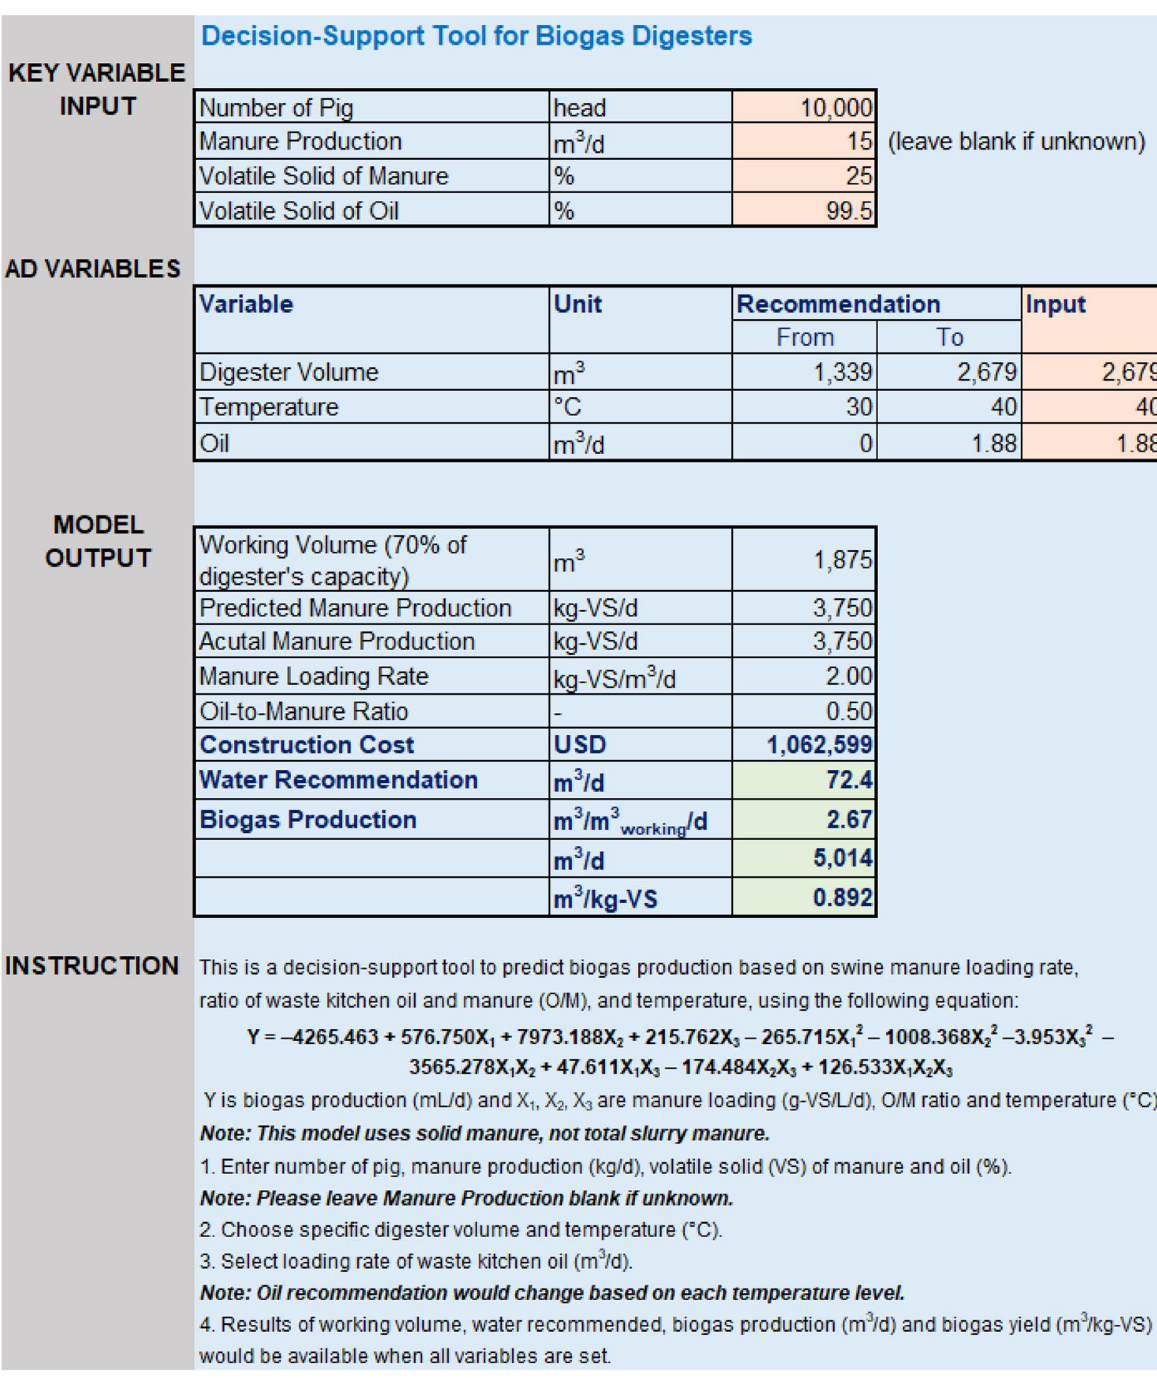
Figure 4. A user-friendly tool for recommendations of digester volume and other working